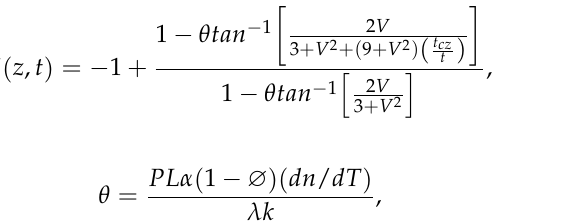
Figure 2. ( a ) Time-resolved Z-scan measurements. Transmittance Z-scan profiles for different final time values: 1.3 ms diamond (green); 3.3 ms stars (red); 13.3 ms circle (blue); and 23.3 ms square (black). Solid lines represent the fittings according to Equation (3a). ( b ) Transient experimental data and corresponding fitting by Equation (3b) for three values of z around the extremums of the signal S in water with ∅ = 0 (the measured values 𝜃 = 0.11 and 𝑡 (cid:3030)(cid:2868) = 0.7 ms) .